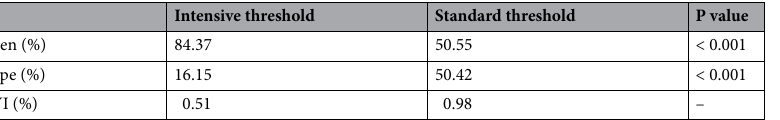
Table 3. The sensitivity, specificity and Youden’s index towards 10-years ASCVD risk estimation (≥ 10%) by different